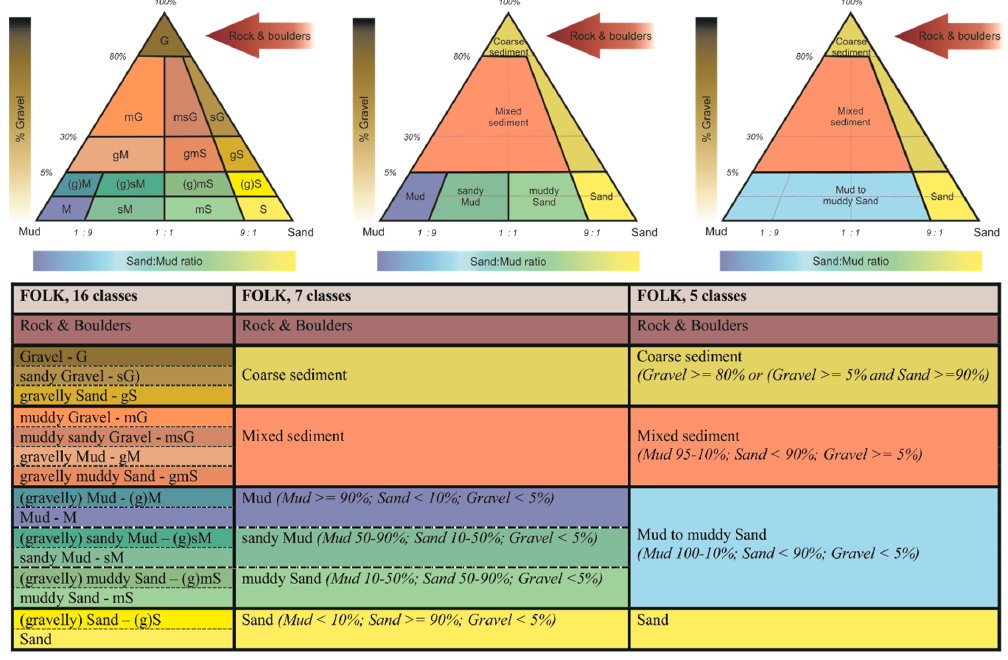
Figure 3. The Folk sediment triangle and the hierarchy of Folk classification (15, 6 and 4 classes, plus an additional class “rock and boulders,” indicated by the arrow) used in the EMODnet Geology